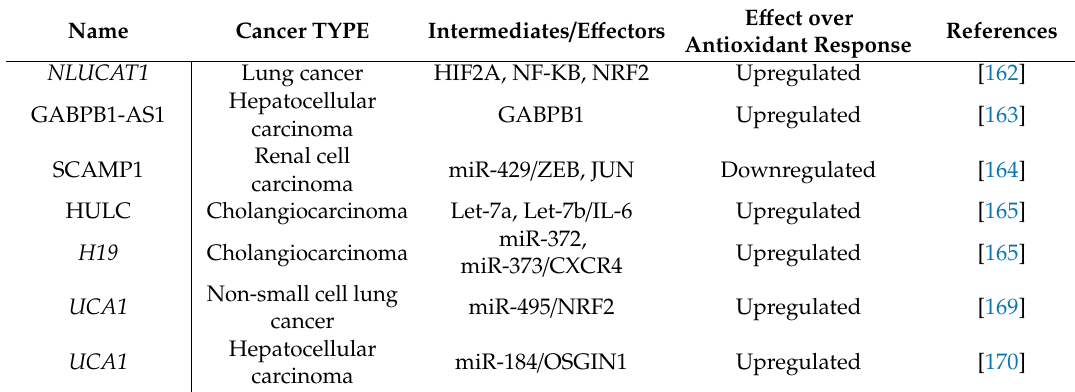
Table 3. Long non-coding RNAs (lncRNAs) regulated by the antioxidant response in cancer